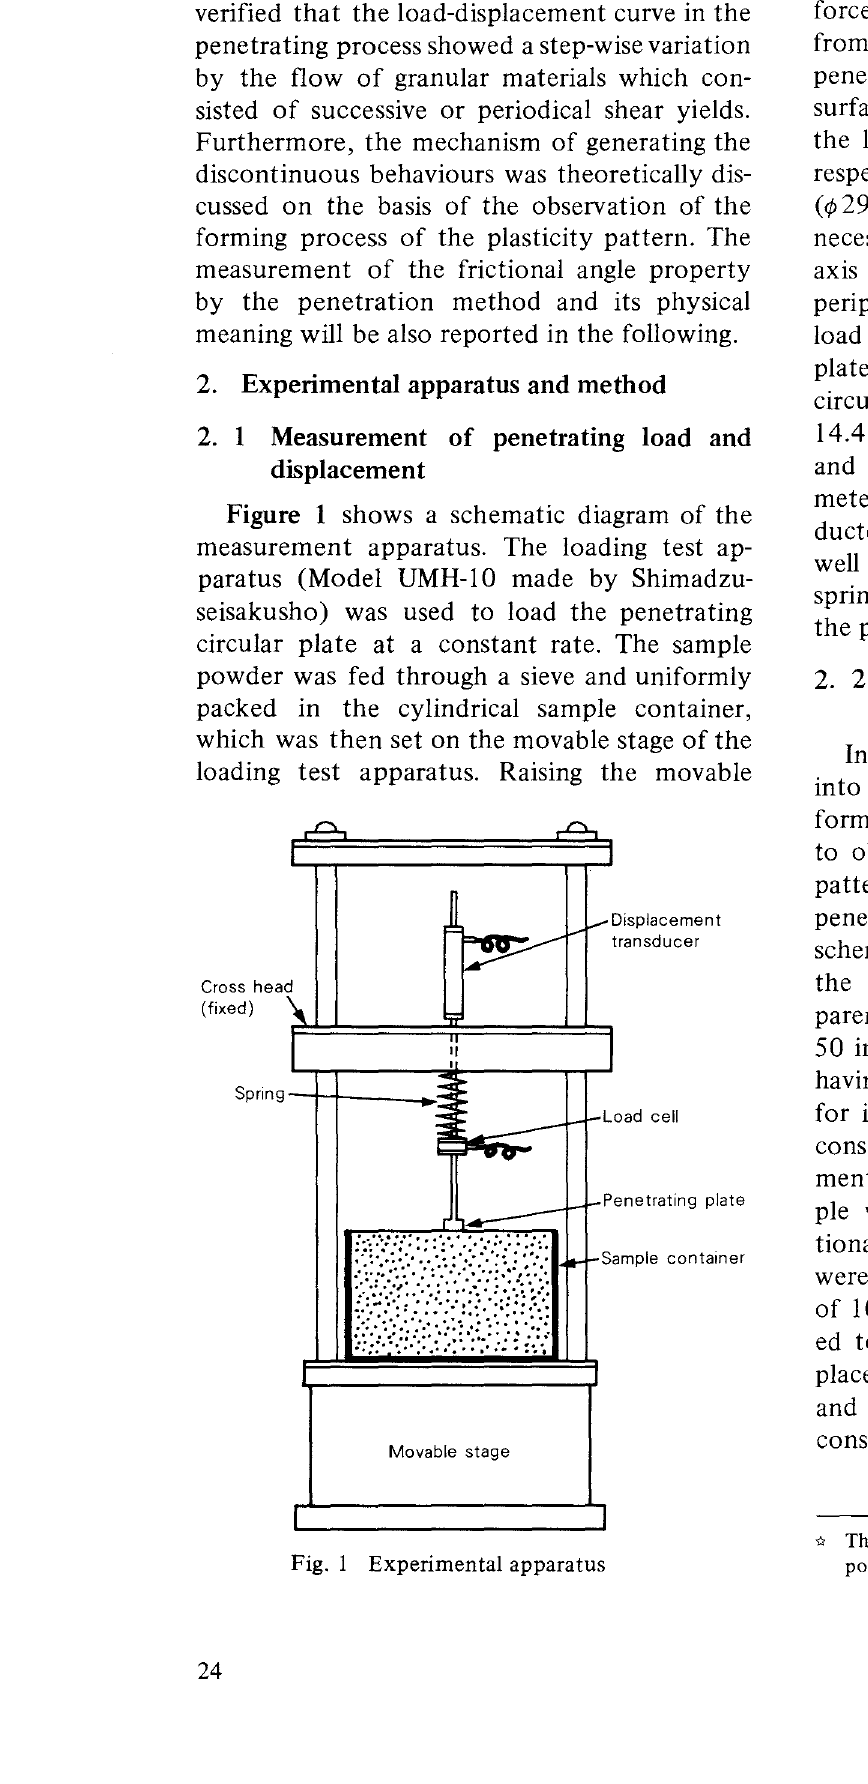
Fig. 1 Experimental